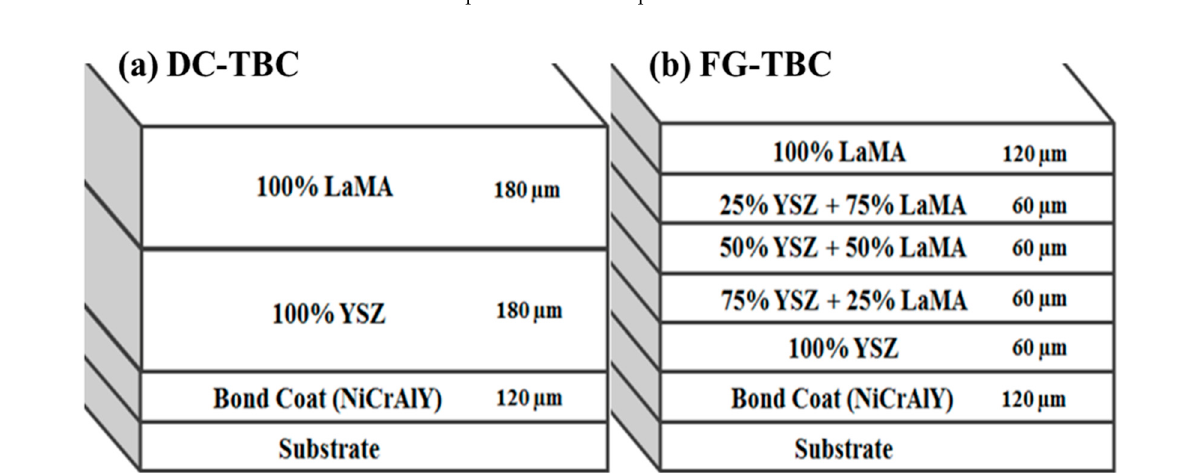
Figure 1. Coating architectures: ( a ) dual-layered architecture, DC-TBC and ( b ) functionally graded architecture, FG-TBC.